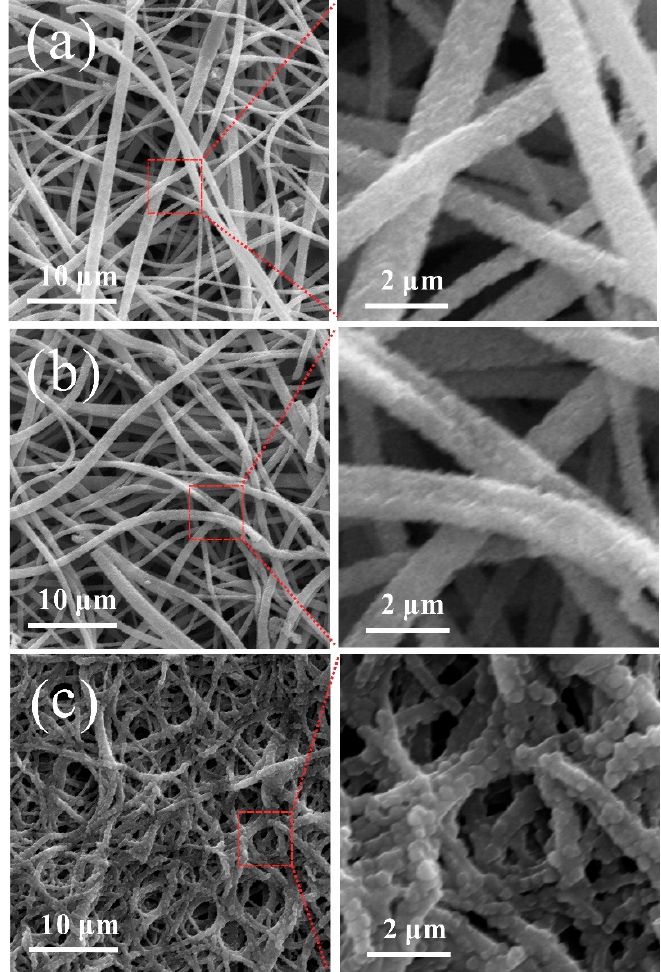
Figure 11. SEM images of ( a ) CNMs, ( b ) CNMs-PC and ( c ) CNMs-CC after 1000 cycles.